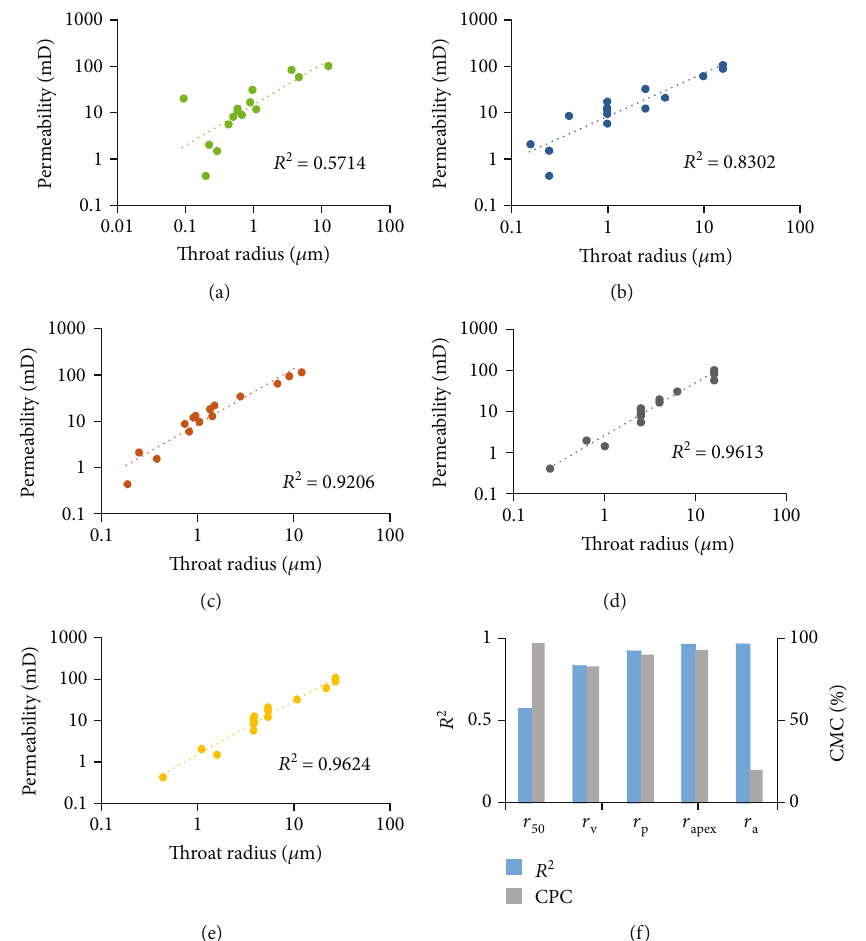
Figure 9: (a) Correlation between r permeability. (d) Correlation between r coe ffi cient and cumulative permeability contribution